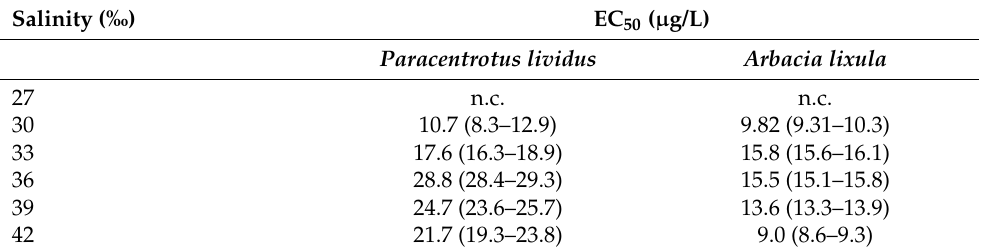
Table 2. Median effective concentration (EC50) of sea urchin embryos exposed to different salinities. Values are reported with respective 95% confidential limits; n.c. = not calculated. Salinity (‰) EC 50 ( µ g/L) Paracentrotus lividus Arbacia lixula 27 n.c.